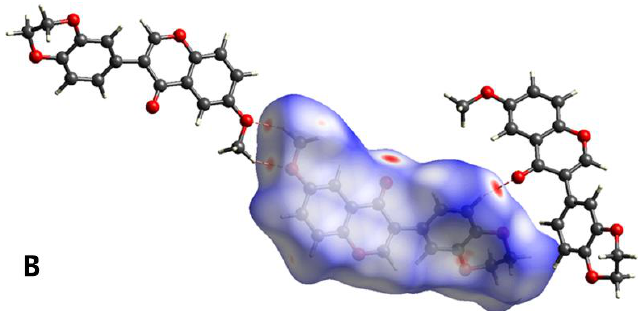
Figure 5. ( A ) Hirshfeld surfaces mapped with d norm , shape index and curvedness. ( B ) Deep red spots on the d norm surface represent close contact interactions with other molecules by dimeric linkage and H-bonds.